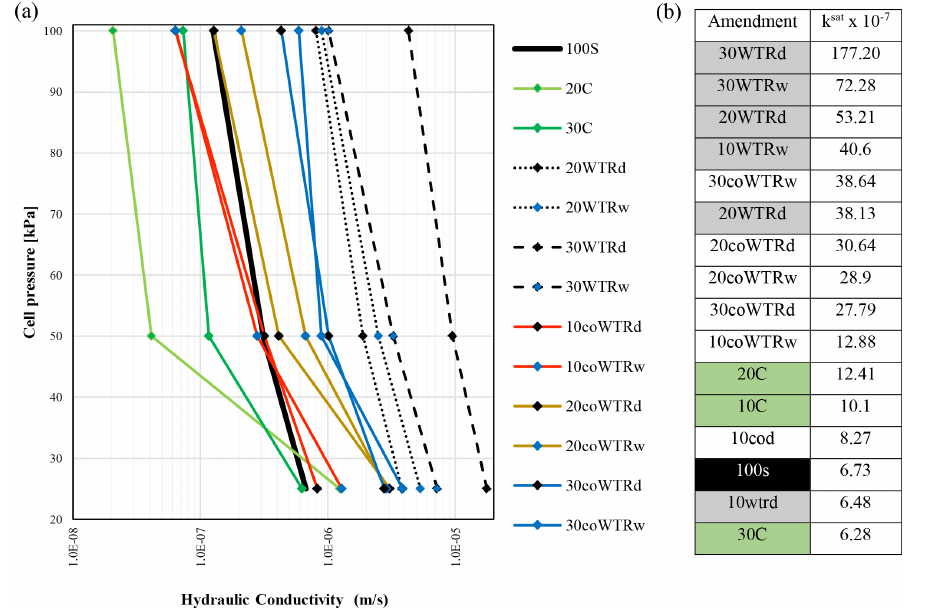
Figure 4. (a) Saturated hydraulic conductivity of samples conducted in a triaxial cell at pressures of 25, 50, and 100kPa, on a log scale. Samples 10C, 10WTRd, and 10WTRw were only tested at 25kPa and do not feature on the graph; their k values were 1 × 10 − 6 , 6 . 48 × 10 − 7 , and 4 . 06 × 10 − 6 ms − 1 respectively. n = 1 for all samples. (b) Ranked conductivity values for all specimens at